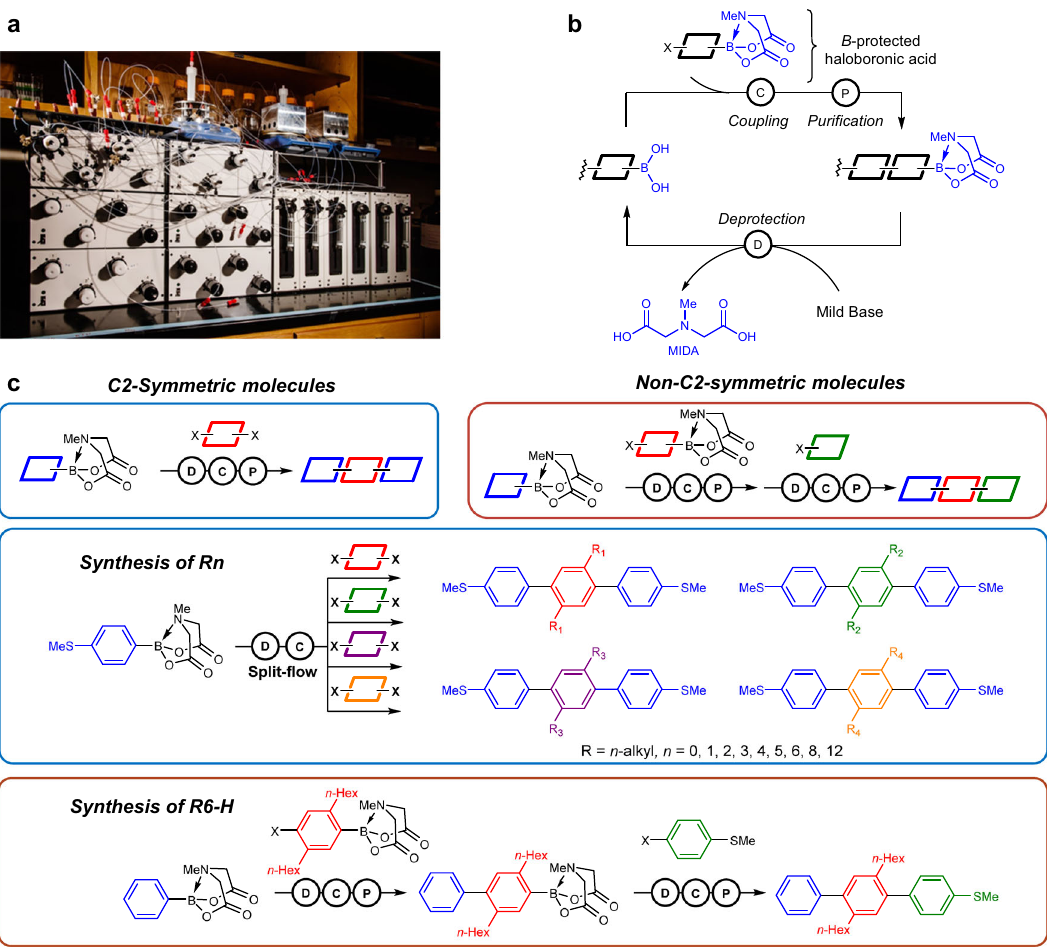
Fig. 1 Automated chemical synthesis of terphenyl derivatives with different side chain compositions. a Picture of the automated synthesis instrument in our lab. b Iterative coupling strategy for small-molecule synthesis using MIDA boronates. c Synthesis schemes for C2-symmetric and non-C2-symmetric terphenyl derivatives via iterative Suzuki